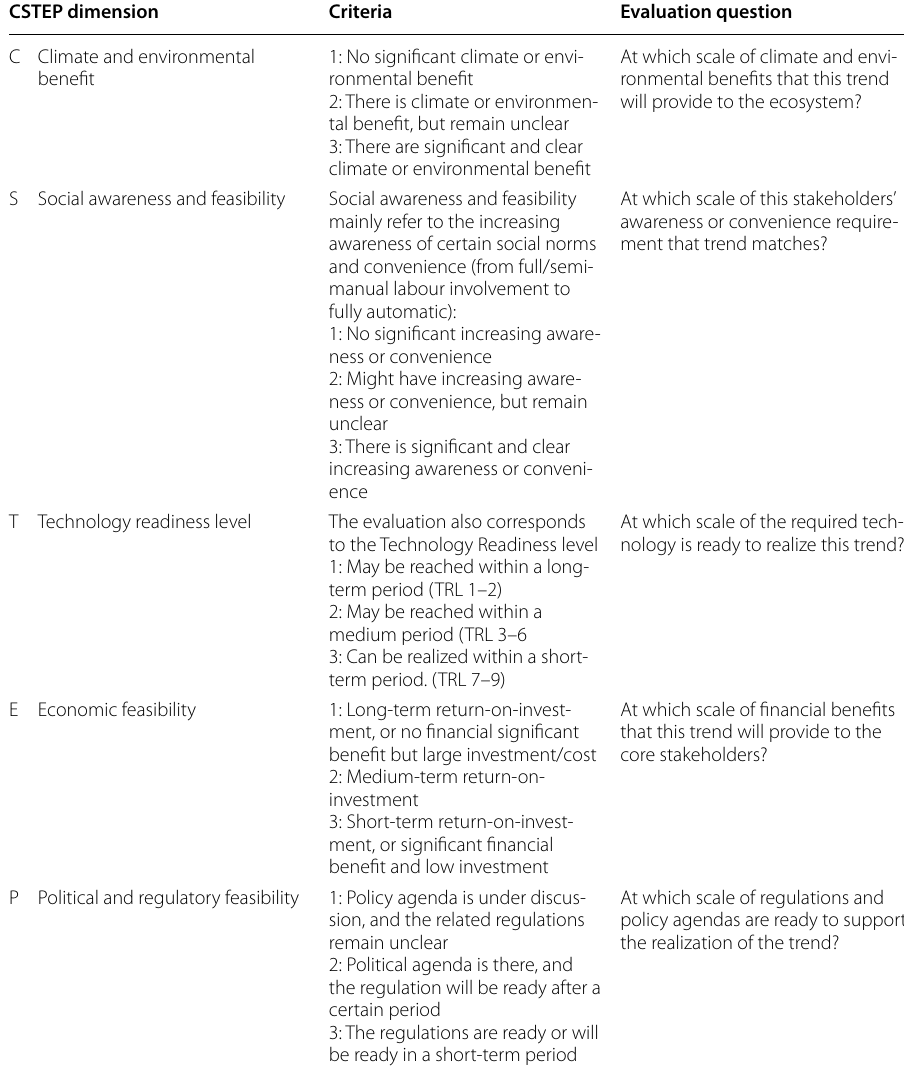
Table 15 CSTEP five-dimensional three-scale evaluation CSTEP dimension Criteria Evaluation